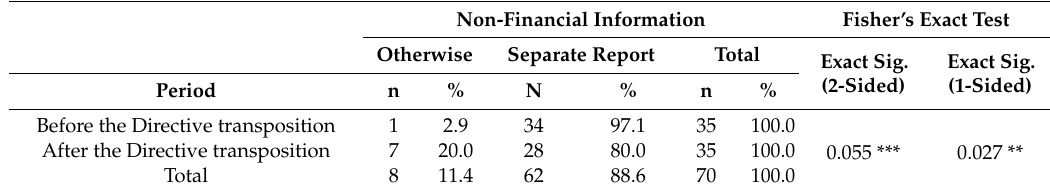
Table 3. Descriptive statistics—Cross-tabulation analysis and Fisher’s exact test.